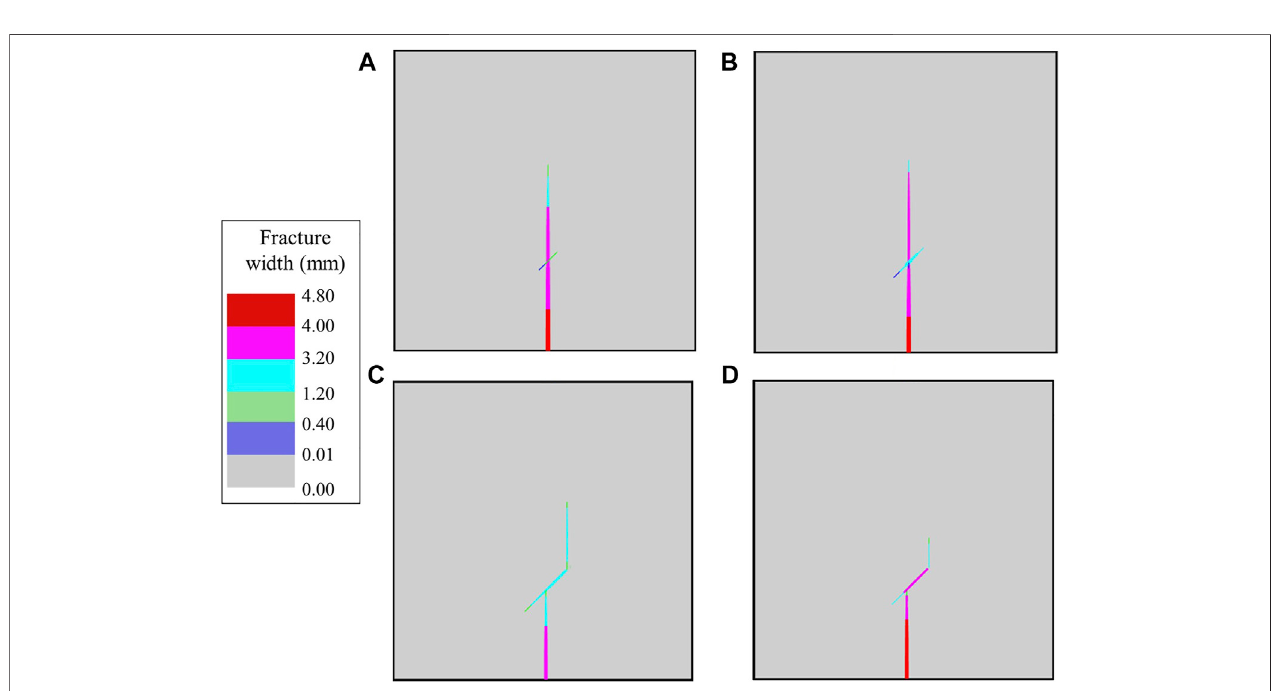
FIGURE 11 | Fracture width and path of the reservoir with a NF with dip angle of 45 ° : (A) 350 mPa · s, (B) 350 → 3 mPa · s, (C) 3 mPa · s, and (D) 3 → 350 mPa · s.